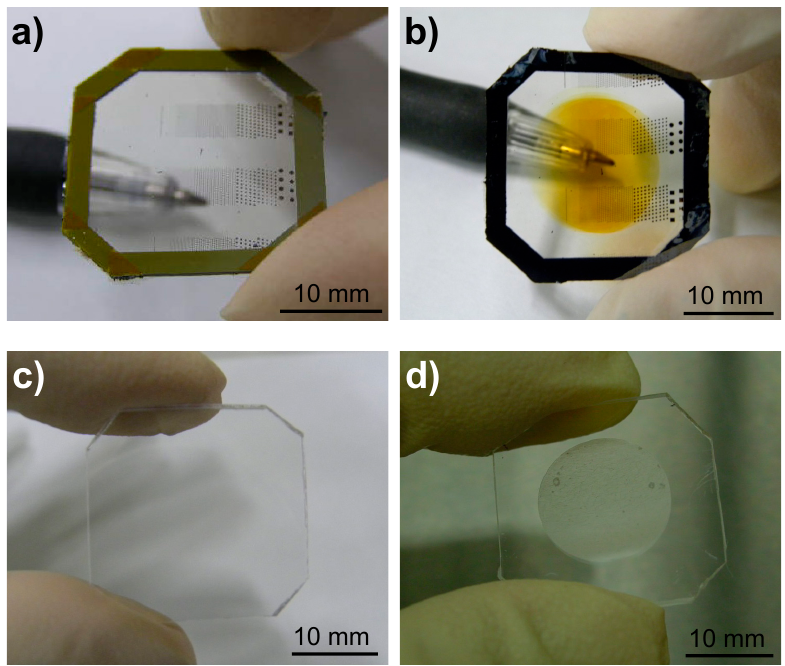
Figure 4. Photographs of X-ray mask ( a ) before; and ( b ) after X-ray irradiation; and of PMMA sheet ( c ) before; and ( d ) after X-ray exposure and